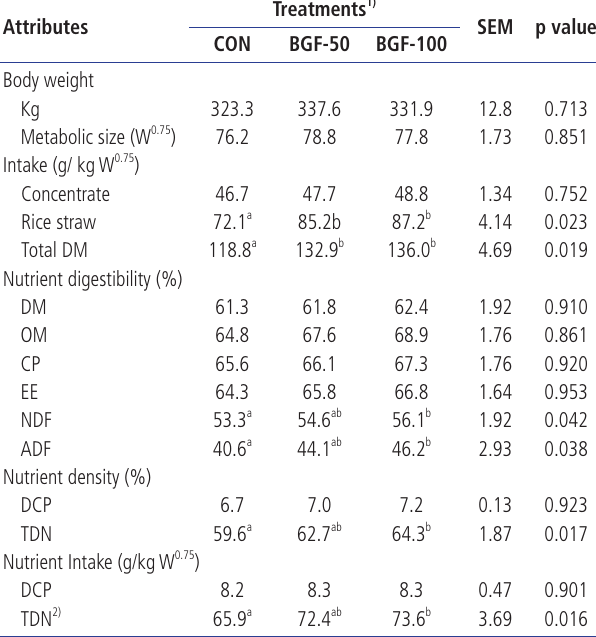
Table 2. Feed Intake, nutrient digestibility and plane of nutrition of crossbred cows supplemented with black gram foliage